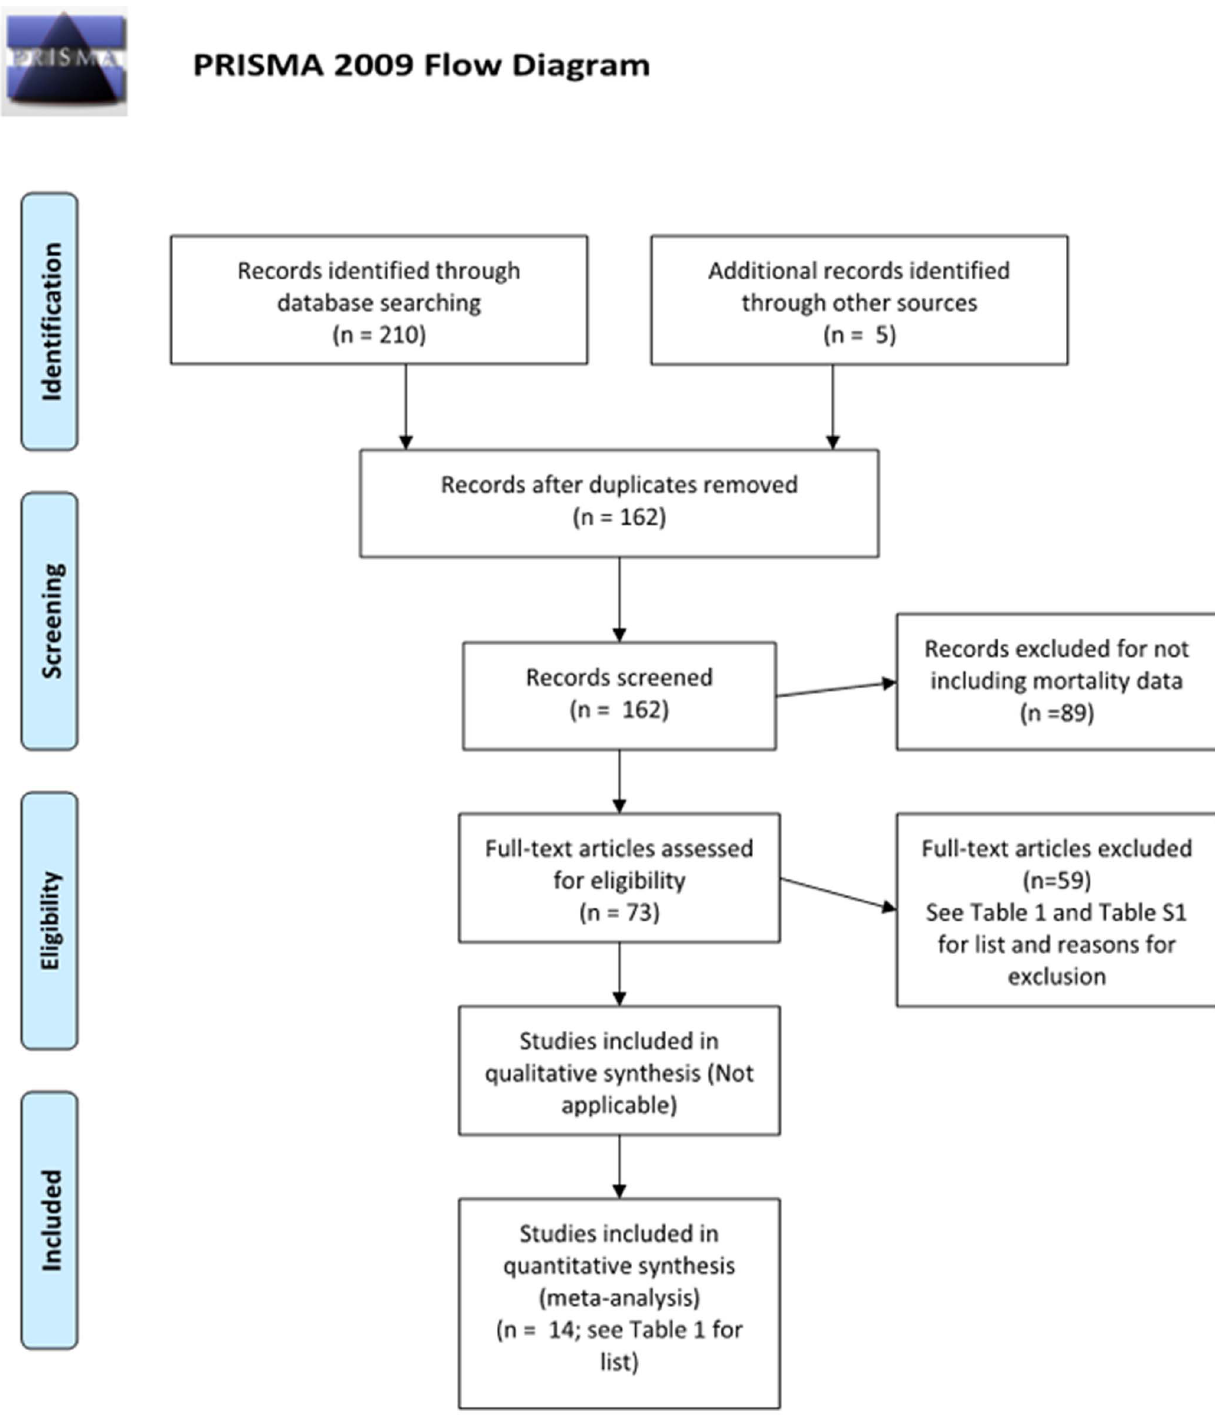
Figure 1. PRISMA flow diagram illustrating the number of independent articles and reports retrieved using the search strategy described under materials and methods, as well as the number of articles screened, excluded, and included in our systematic analysis of bird mortality from collision and electrocution at U.S. power lines. doi:10.1371/journal.pone.0101565.g001 Relaxing Inclusion Criteria to Increase Sample Size We felt that all inclusion criteria were necessary for producing the least biased mortality estimates possible; however, after Table S1, but not in the main manuscript, are in Text S2. implementing all criteria and extracting data, only 17 mortality